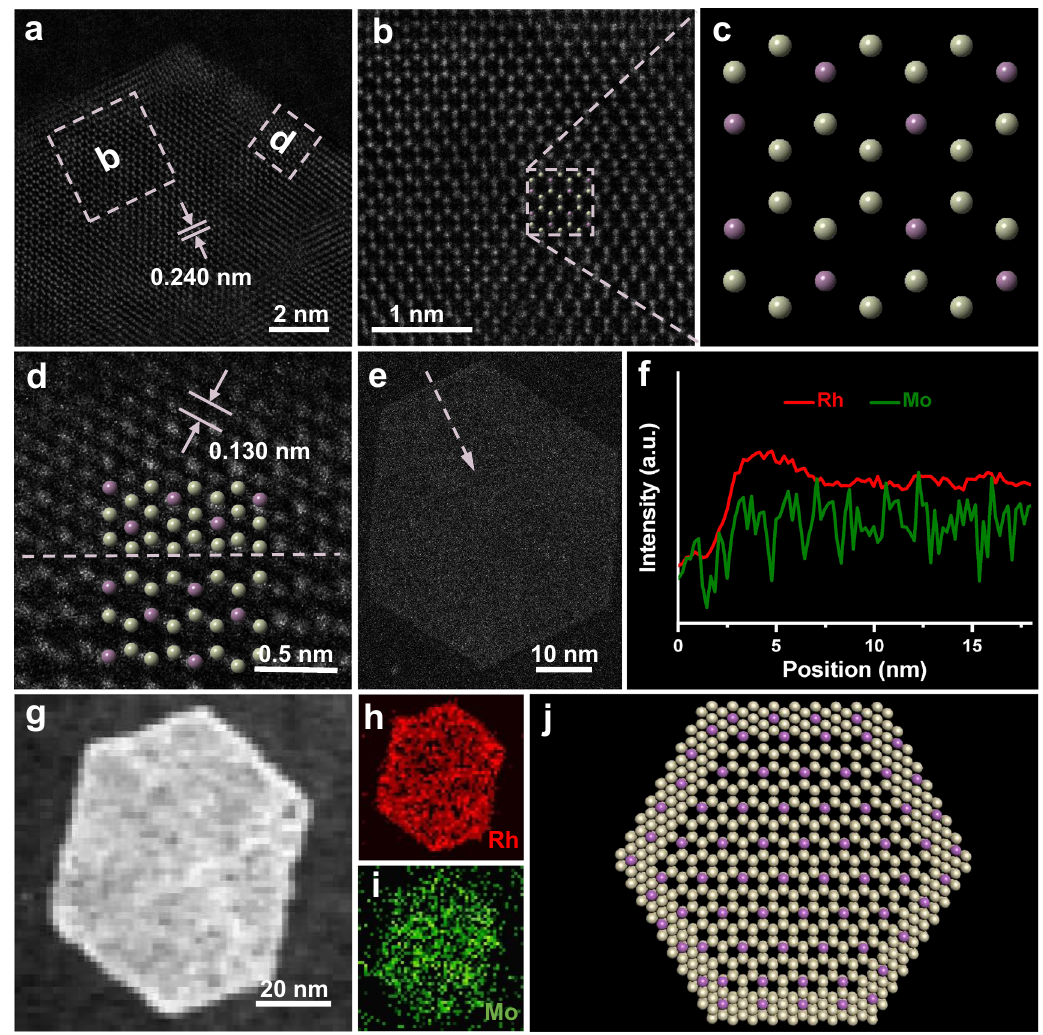
Fig. 2 | Structural analysis of RhMo NSs. a HAADF-STEM image from a single RhMo NS. b and d are high-resolution HAADF images from the remarked areas in ( a ). c is a model of atomic arrangement remarked in ( b ). e HAADF- STEM image and f corresponding EELS spectroscopy line-scan pro fi les of a